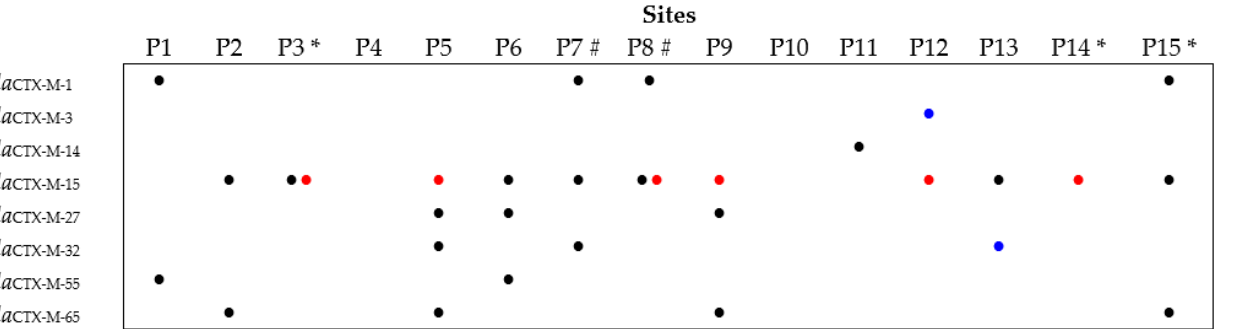
Figure 3. CTX-M encoding genes detected in the Lis riverine system. Black dots for Escherichia isolates, red for Klebsiella , and blue for Citrobacter or Enterobacter . Sites located downstream WWTP and in the vicinities of pig farms are indicated by * and #, respectively.